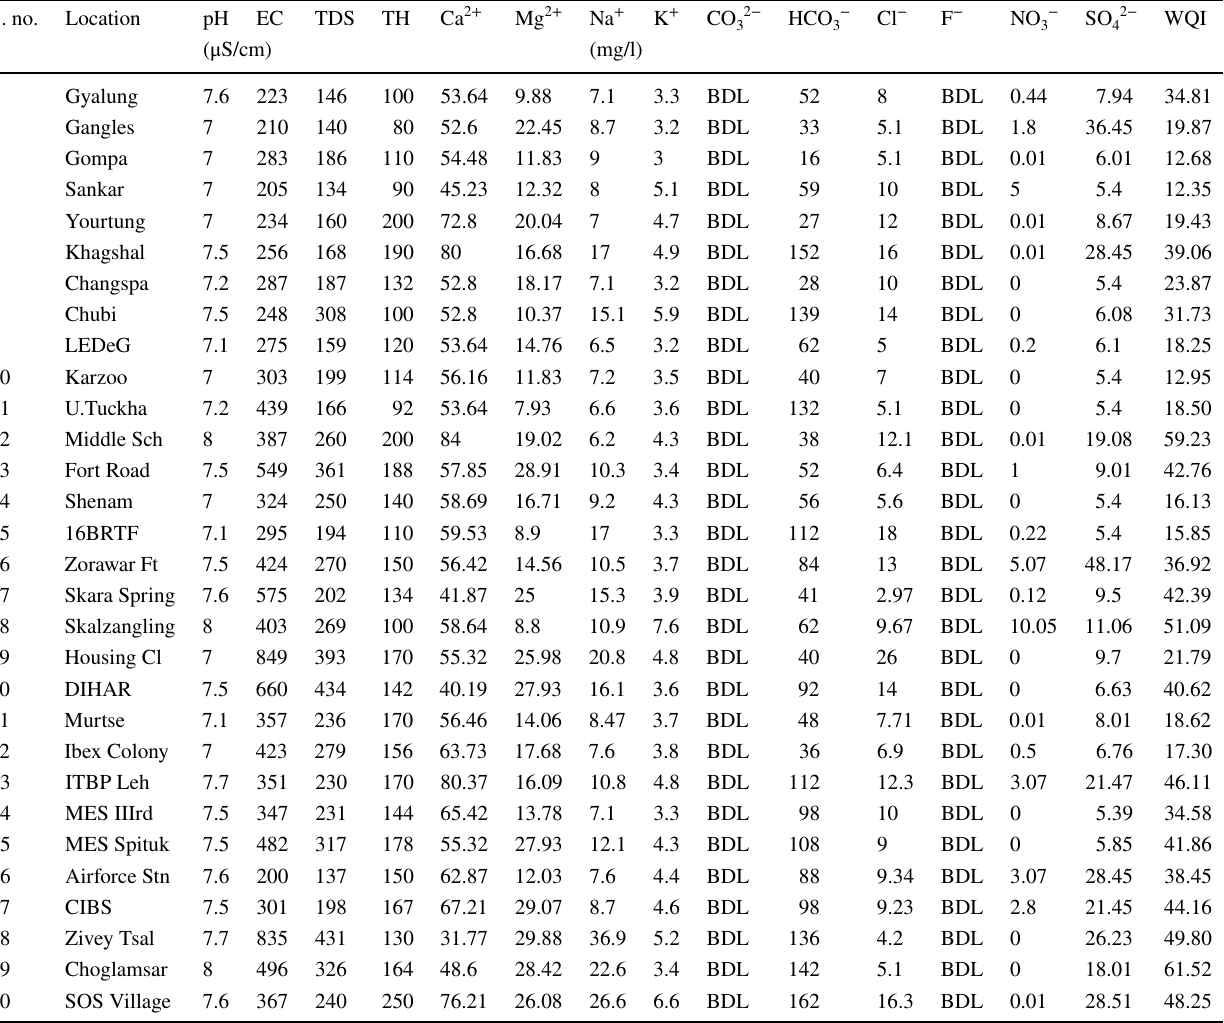
Table 1 Results of groundwater sample analysis during pre-monsoon/pre-tourist season